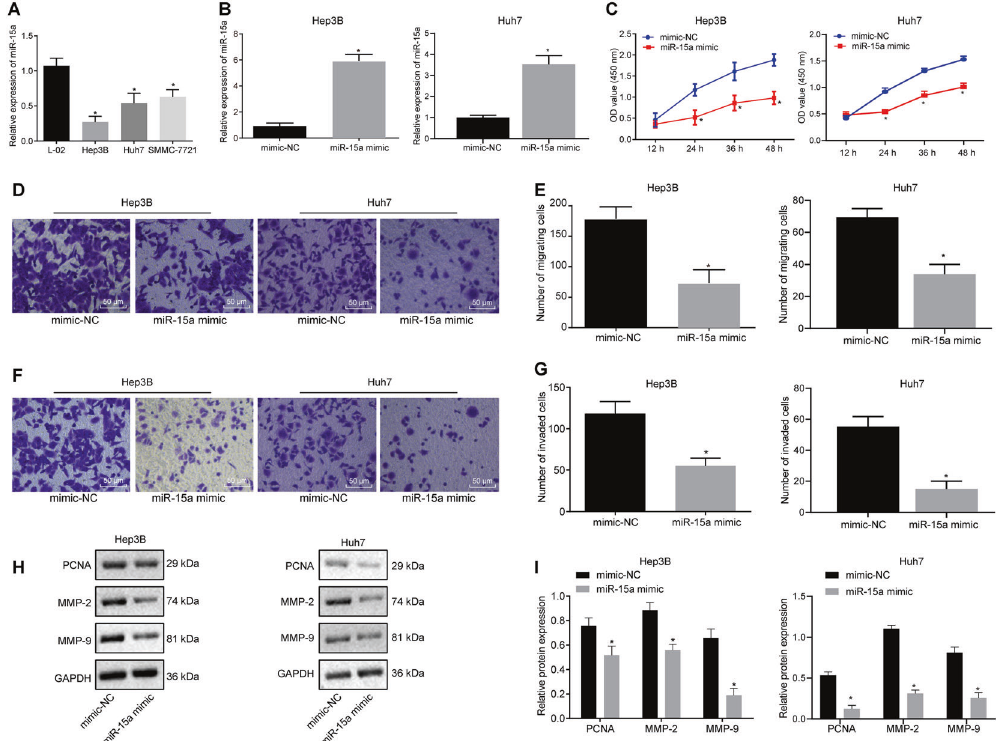
Fig. 3 miR-15a suppresses the proliferation, migration, and invasion of HCC cells in vitro. A Expression of miR-15a was determined by RT- qPCR in normal hepatocytes L-02 and HCC cells Hep3B, Huh7, and SMMC-7721, relative to U6. B Expression of miR-15a was determined by RT-qPCR in Hep3B and Huh7 cells upon miR-15a mimic transfection, relative to U6. C Proliferation of Hep3B and Huh7 cells was detected by CCK-8 assay upon miR-15a mimic transfection. D Migration of Hep3B and Huh7 cells was detected by transwell assay upon miR-15a mimic transfection (×200). E Statistical analysis of panel D . F Invasion of Hep3B and Huh7 cells was detected by transwell assay upon miR-15a mimic transfection (×200). G Statistical analysis of panel F . H Representative western blots of MMP-2, MMP-9, and PCNA proteins in miR-15a mimic-transfected Hep3B and Huh7 cells. I The quantitation of panel H . * p < 0.05 vs. L-02 cells or Hep3B and Huh7 cells transfected with mimic-NC. Data in panel C were analyzed by repeated-measures ANOVA with Bonferroni post hoc testing, data in panels B , E , G and I were analyzed by unpaired t -test, and data in panel A were assessed by one-way ANOVA followed by Tukey ’ s post hoc test. Data are shown as mean ± standard deviation of three technical replicates.